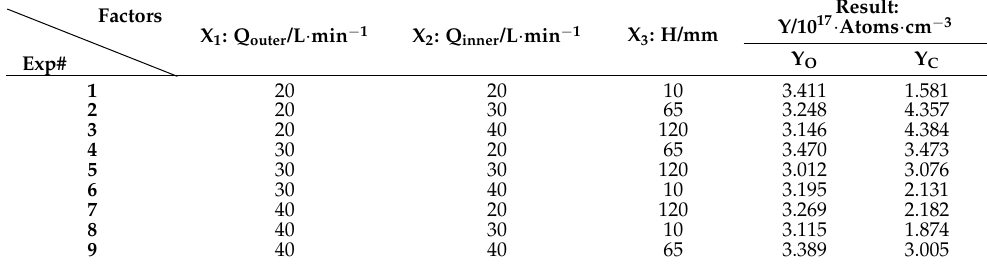
Table 3. Cases and results of the orthogonal experiment design.